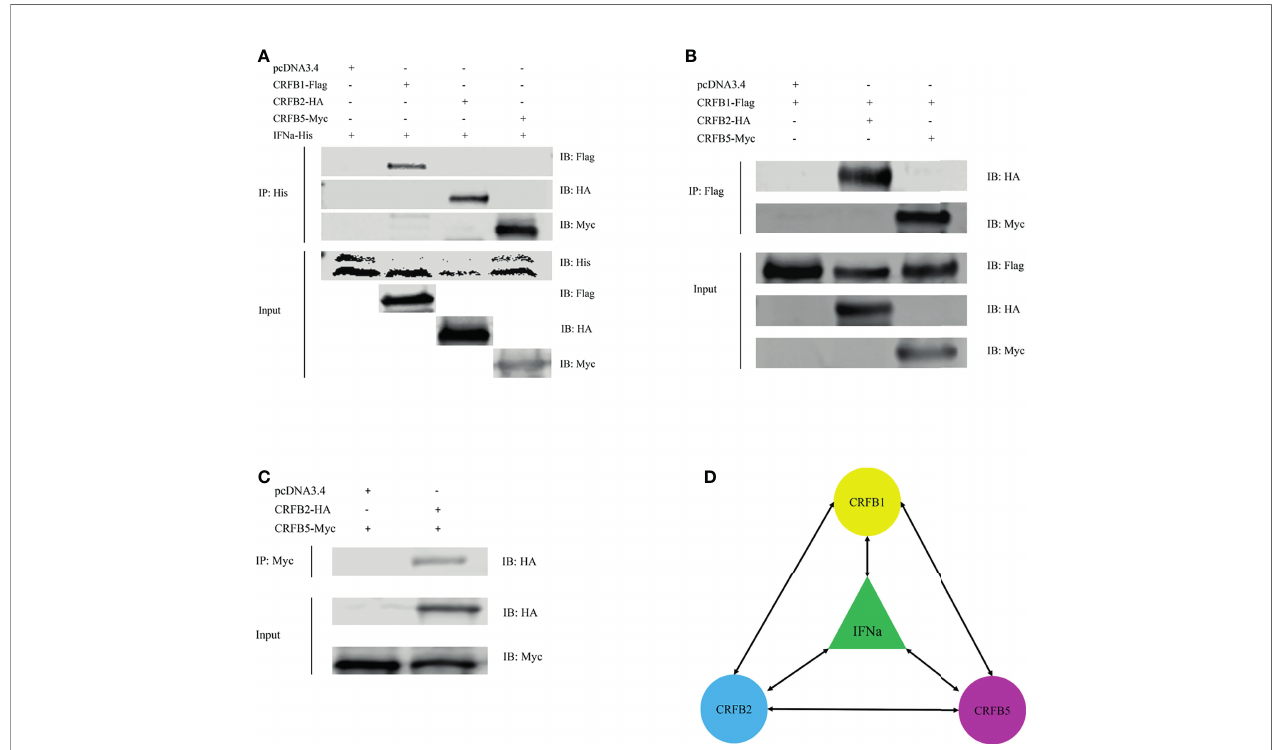
FIGURE 6 | Ci IFNa interacts with CRFB1, CRFB2, and CRFB5. The HEK293 cells were transfected with the respective plasmids (2.5 m g each). After 24 h, cell lysates were immunoprecipitated (IP) with antibody agarose resin. The immunoprecipitates and cell lysates were analyzed by immunoblotting (IB) with the anti-His, anti-Flag, anti-HA, or anti-Myc Abs. (A) Interaction of CiIFNa with CRFB1, CRFB2 and CRFB5. (B) Interaction of CRFB1 with CRFB2 and CRFB5. (C) Interaction between CRFB2 and CRFB5. (D) Diagram description of interactions between CiIFNa and receptors. Bidirectional arrows indicate interaction. "+"=transfected, "-"=not